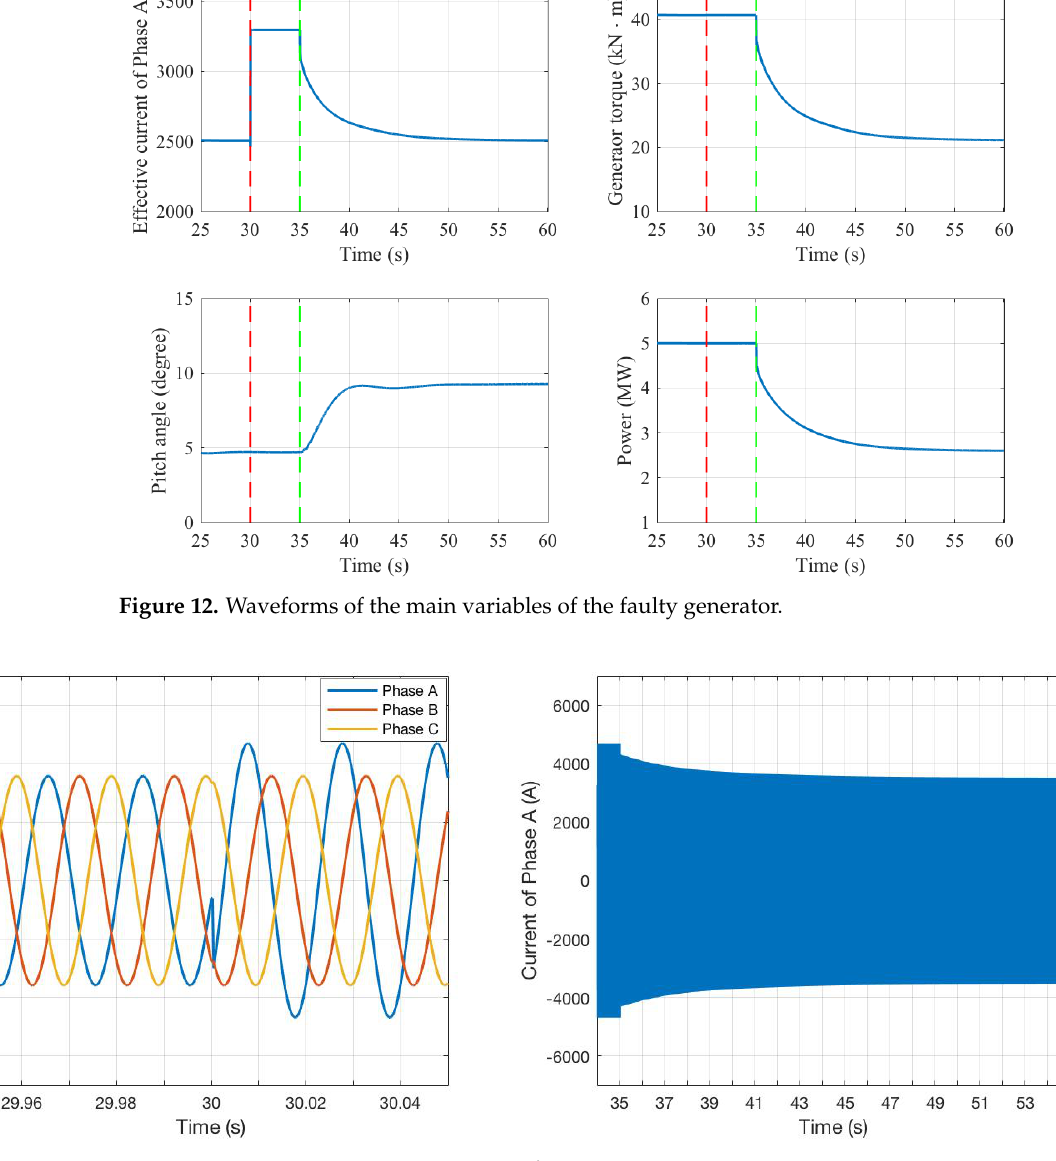
Figure 13. Current